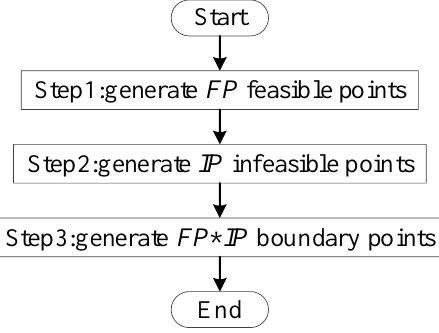
Figure 5. The flowchart for the calculation of boundary region.